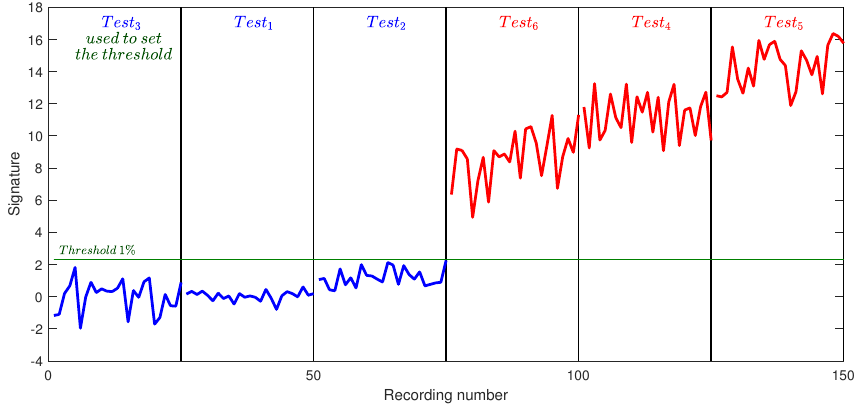
Figure 16. Signatures, 2 period, N ref =